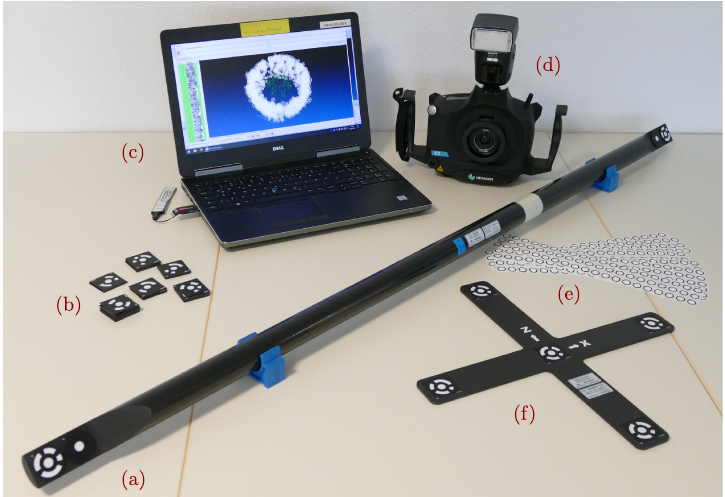
Figure 4. Hexagon’s Aicon DPA Industrial measurement system consisting of the C1 camera ( d ) with a 28mm metric lens, a coordinate-cross ( f ) for initial datum definition during the measurement process, scale bars ( a ) to trace to the SI meter, circular coded ( b ) and uncoded ( e ) photogrammetric markers, and the software package Aicon Studio 3D ( c ) for data analysis. In this campaign, uncoded and 14-bit coded circular black-and-white markers are used. About 175 coded markers at the dome wall establish the photogrammetric reference frame. The frame is temporarily enlarged for the vertical component by further 50 coded markers beyond the wall of the dome. The scale information for the photogrammetric reference frame results from three calibrated scale bars, which are traced to the SI meter. The scale bars are located surrounding the telescope and contribute to all three coordinate